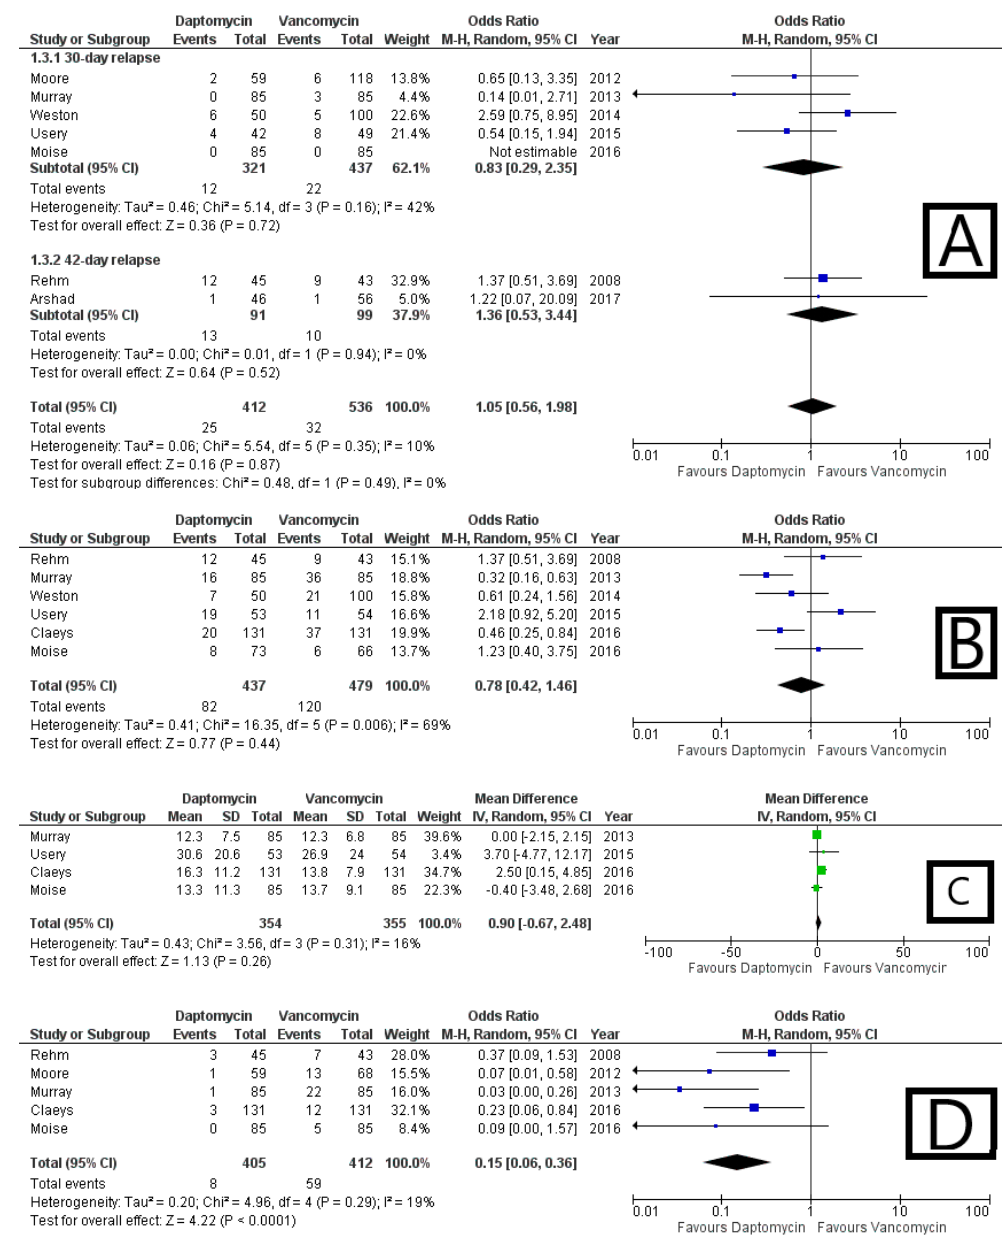
Antibiotics 2021 , 10 , x FOR PEER REVIEW Figure 4. Forest plot depicting the adjusted odds ratio of clinical failure of patients receiving daptomycin vs. vancomycin.